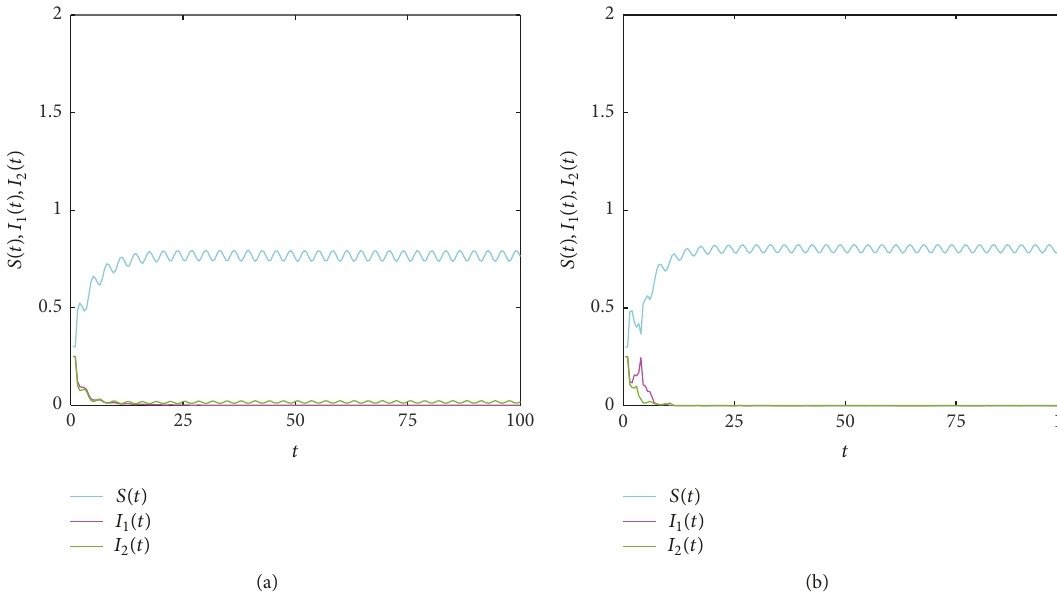
Figure 3: The solution (𝑆(𝑡),𝐼 1 (𝑡),𝐼 2 (𝑡)) = (0.3, 0.25, 0.25) to the nonautonomous stochastic model